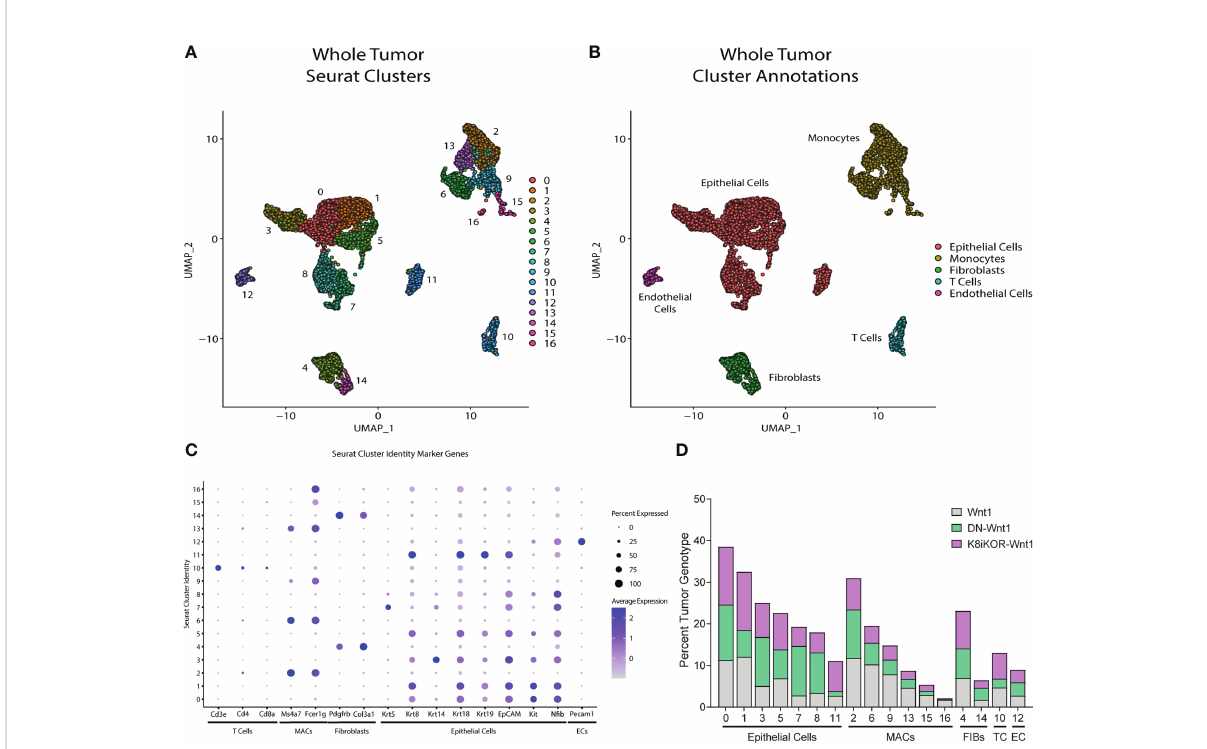
FIGURE 3 Identifying mammary tumor heterogeneity by single cell RNA-sequencing. (A) Uniform Manifold Approximation and Projection (UMAP) plot of cells from Wnt1, DN-Wnt1, and K8iKOR-Wnt1 tumors resulting in 17 individual clusters. (B) UMAP plot with identi fi cation of cluster cell types de fi ned by known markers. (C) Dot plot of cell markers. (D) Percent tumor genotype graph for each cluster. Clusters are ordered by identi fi ed tumor cells. MAC and T-cell populations were generally decreased in DN-Wnt1 and K8iKOR-Wnt1 tumors. (MACs = monocytes/macrophages, TC = T cells, FIBs = fi broblasts, EPI = epithelial cells, EC = endothelial